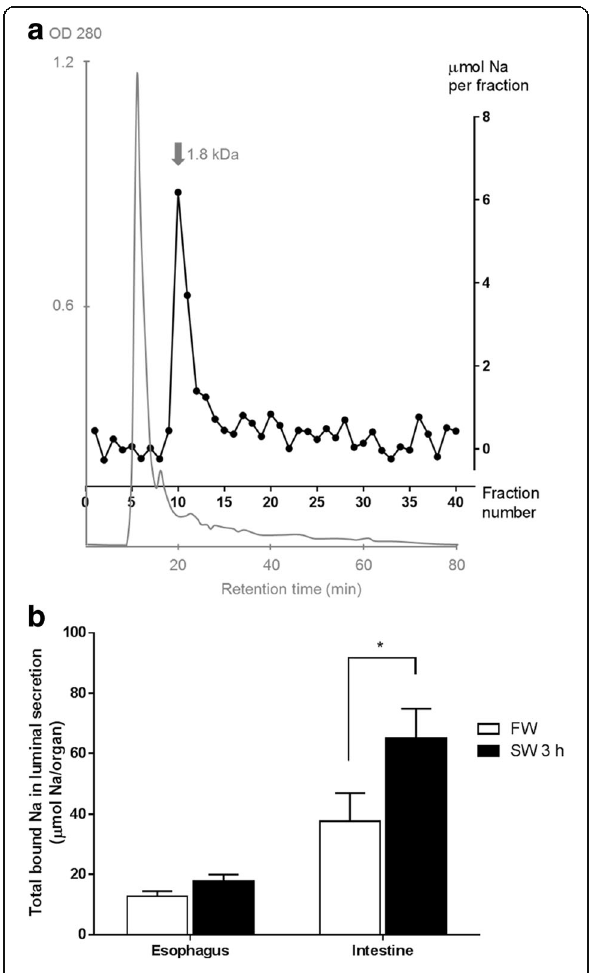
Fig. 7 Partial purification of Na-binding molecules from esophageal and intestinal luminal secretion using gel filtration HPLC. a A representative chromatograph (OD 280 nm) showing the separation of a FW esophageal luminal secretion sample (grey, left Y-axis). The gel filtration column is equilibrated with 0.1 M Tris-HCl (pH 7.4) at a flowrate of 0.5 mL/min. Large proteins (> 4 kDa) and free Na are eluted at the flow through (10 – 15 min). The Na content of each 2 min fraction (black, right Y-axis) was superimposed on the chromatograph to indicate the relationship among molecular size, protein quantity, and Na-binding capacities. A bound-Na peak is present with molecular size ~1.8 kDa. b Effects of 3 h SW transfer on the total bound Na in the luminal secretions of eel esophagus and intestine ( N = 5). Total bound Na is defined as the sum of Na contents in non-flow-through fractions in A). Statistical difference between salinity treatment in the same tissue is indicated by * ( p < 0.05) after two way ANOVA, Bonferroni ’ s test